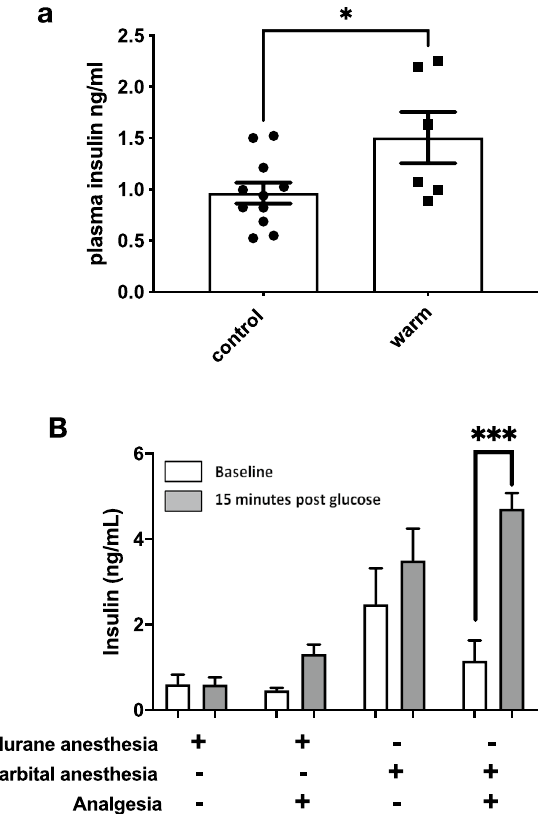
Figure 5. Impact of temperature, anesthesia and analgesia. ( a ) GSIS in anesthetized mice with the pancreas exteriorized and sandwiched on a slide on plastic spacers (control), or on copper tubing (warm). ( b ) Comparison of GSIS on animals with either isoflurane or pentobarbital and with or without analgesia. *p < 0.05, ***p <